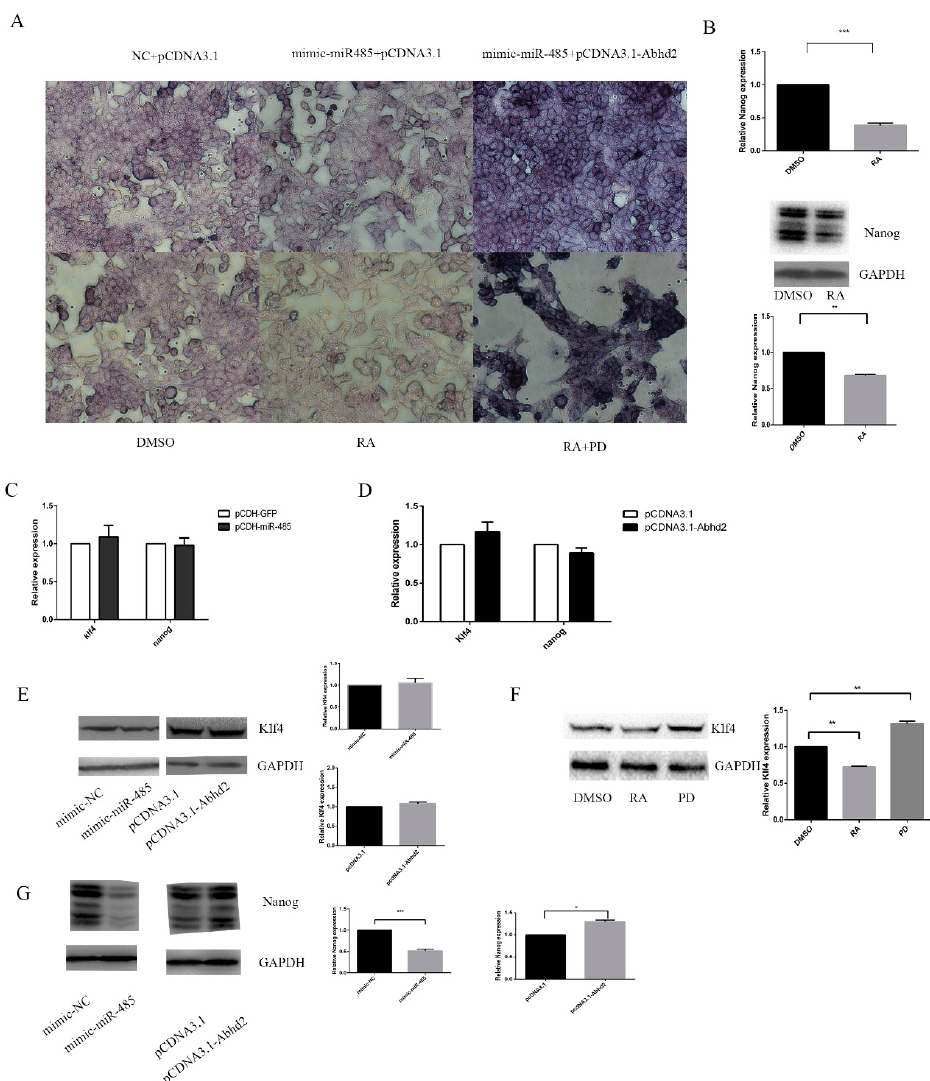
Figure 5. miR-485 and abhd2 influence cell differentiation by modulating Nanog. ( A ) Alkaline phosphatase activity staining of F9 ECs with different treatments. The vector pCDNA3.1 and pCDNA3.1-Abhd2, mimic-NC or mimic-miR-485 were transfected into F9 ECs for 36 h. after transfection 6 h, 2 μ M RA, PD or DMSO was added into medium. The activities of AP were shown, and cells were captured under 400×. ( B ) qPCR and Western Blot analysis of Nanog. Up panel: qPCR analysis of nanog after 36 h of treatment with DMSO or RA. Bottom panel: Western Blot analysis of Nanog after 36 h of treatment with DMSO or RA, and protein bands were quantified by using ImageJ software and calculated by using the samples normalized to Gapdh. Data are presented as the mean ± SD of three independent experiments (* p < 0.05; ** p < 0.01; *** p < 0.001). ( C ) qPCR analysis of the expression of Klf4 and Nanog after 36 h transfection with mimic-NC or mimic-miR-485. ( D ) qPCR analysis of the expression of Klf4 and Nanog after 36 h transfection with pCDNA3.1 or pCDNA3.1-Abhd2. ( E ) Western Blot analysis of the expression of Klf4. F9 ECs were cultured in DMEM medium were transfected with pCDNA3.1, pCDNA3.1-Abhd2, mimic-NC or mimic-miR-485 for 36 h. Left panel: Western Blot analysis of the expression of Klf4. Right panel: the statistical analysis of Western Blot. ( F ) Western Blot analysis of Klf4 after 36 h of treatment with DMSO, RA or PD. Left panel: Western Blot analysis of the expression of Klf4. Right panel: the statistical analysis of Western Blot. ( G ) Western Blot analysis of the expression of Nanog after 36 h transfection with mimic-NC or mimic-miR-485, pCDNA3.1 or pCDNA3.1-Abhd2. Left panel: Western Blot analysis of the expression of Nanog. Right panel: the statistical analysis of Western